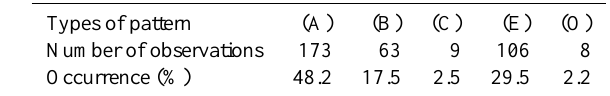
Table 2. Statistics of the observations over the year